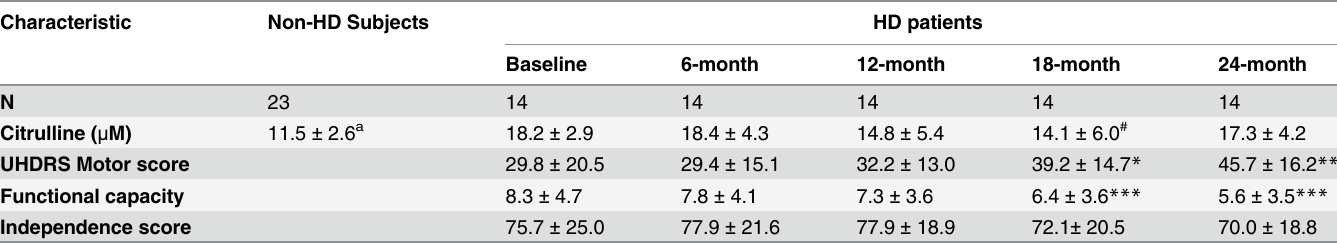
Table 2. UHDRS and blood citrulline concentrations in HD